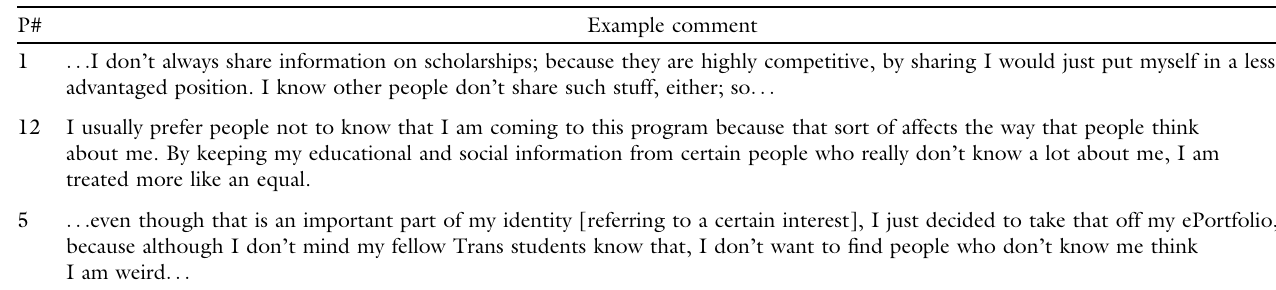
Table 2. Sample user quotes on privacy concerns.